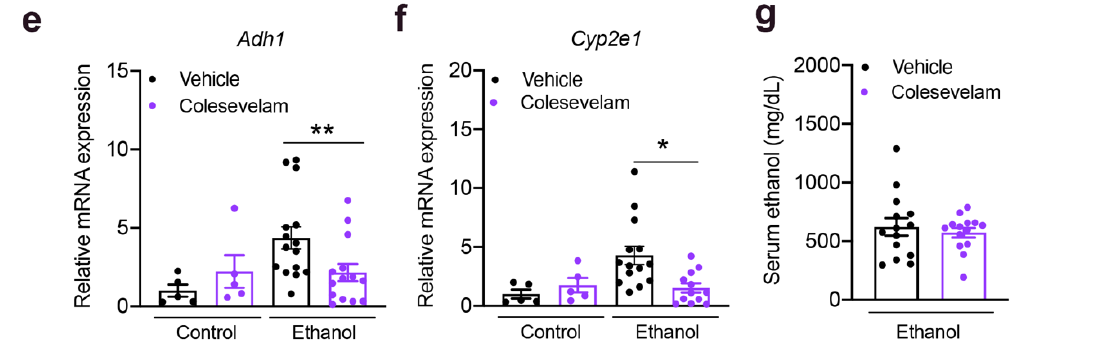
Figure 2. Colesevelam administration in gnotobiotic mice subjected to the chronic-plus-binge ethanol feeding model. C57BL/6 germ-free mice were colonized with feces from two patients with alcoholic hepatitis and subjected to the chronic- binge ethanol feeding model ( n = 15 in vehicle and n = 14 colesevelam treatment) or isocaloric diet ( n = 5 per group), and given vehicle or colesevelam in the liquid diet. ( a ) 16S rRNA analysis of stool from the two patients with alcoholic hepatitis. ( b ) Body weight. ( c ) Liver weight. ( d ) Food intake. ( e , f ) Hepatic Adh1 and Cyp2e1 mRNAs. ( g ) Serum level of ethanol. Results are expressed as mean ± s.e.m. p values were determined by one-way ANOVA with Tukey’s post-hoc test. * p < 0.05, ** p < 0.01.